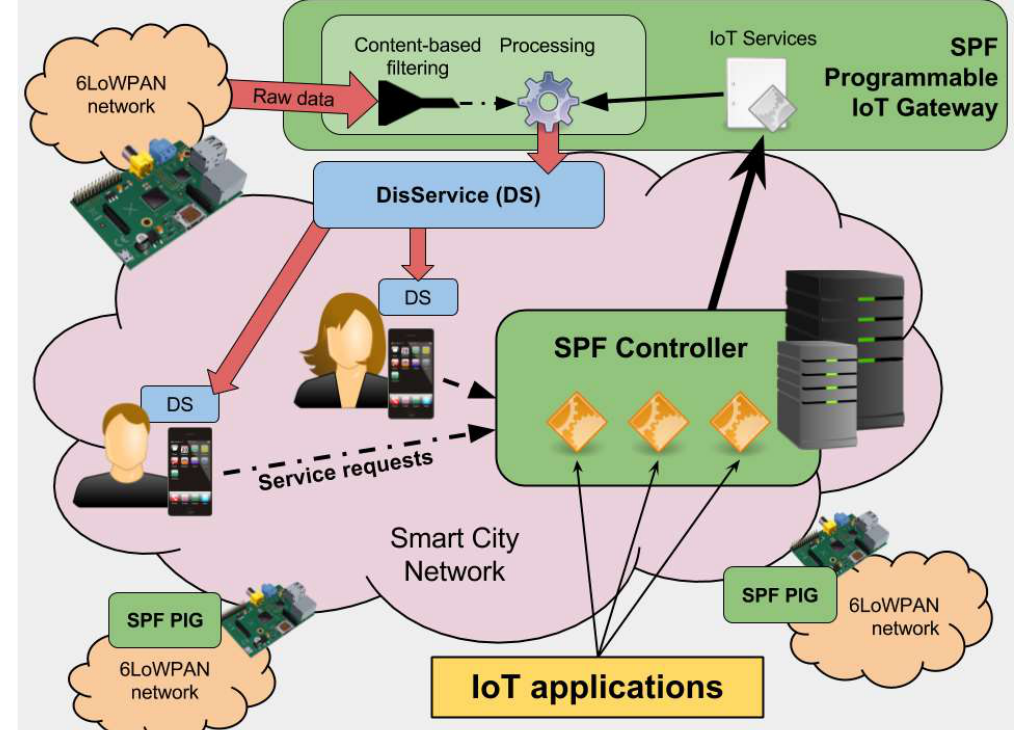
Figure 2. Adoption of SPF in a smart city